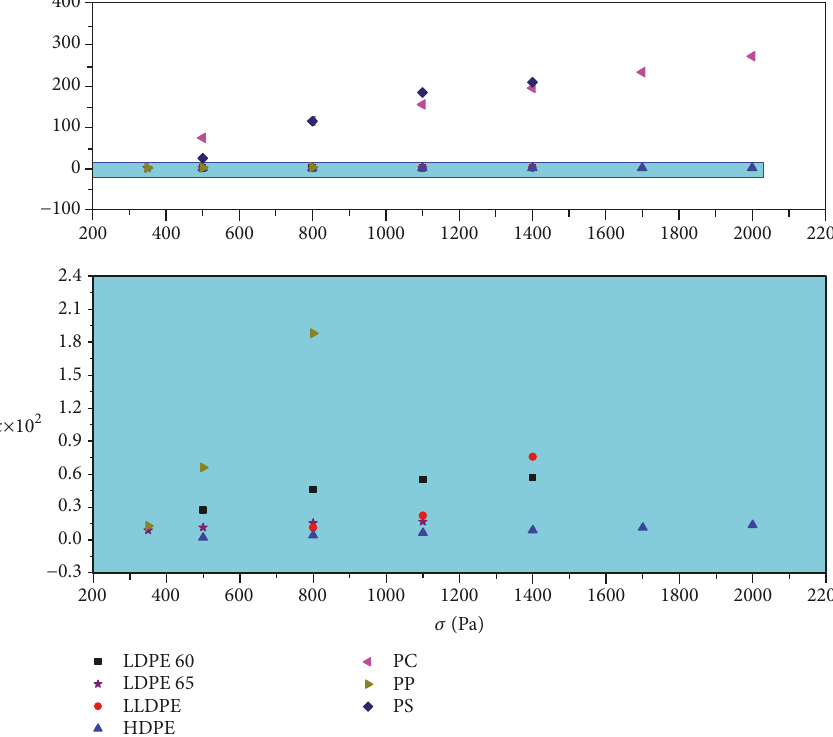
Figure 10: The elongational stress dependency of computed 𝜅 calculated by (7) and